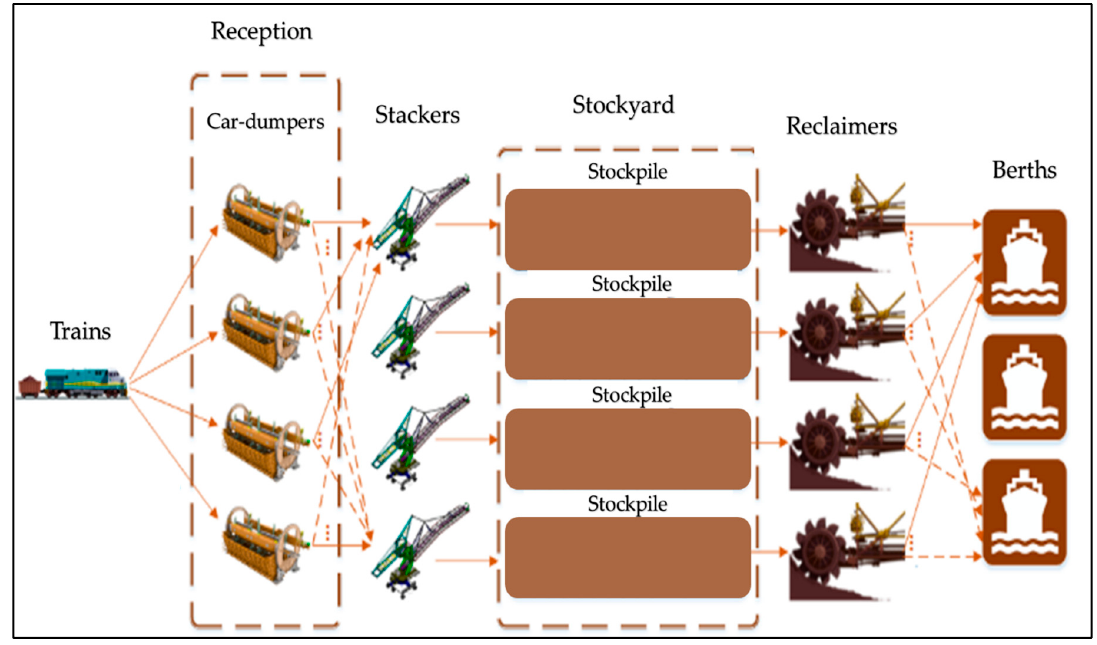
Figure 1. Diagram of the iron ore stockyard.